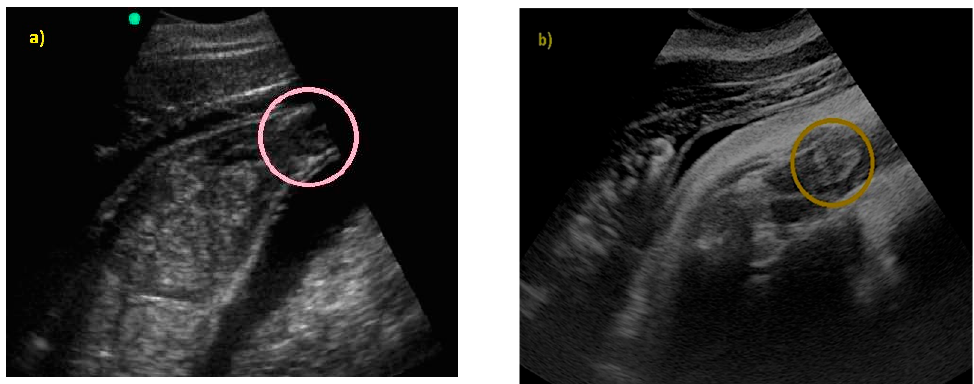
Figure 9. ( a ) An ultrasound image of female genitals (apricot-shaped) by SonoSite 180 Plus with a 2– 5 MHz convex probe; ( b ) the same area caught with General Electrics Logiq V2, with a 2–5 MHz convex probe.